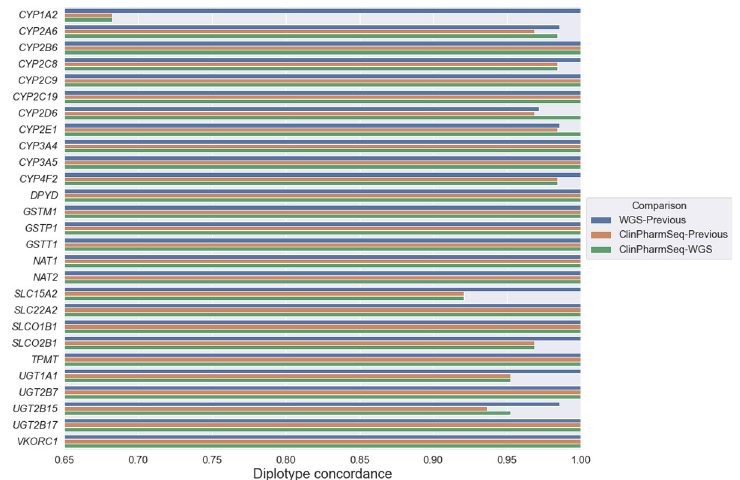
Fig 3. Concordance of diplotype calls for 27 pharmacogenes between WGS, ClinPharmSeq, and previous studies.